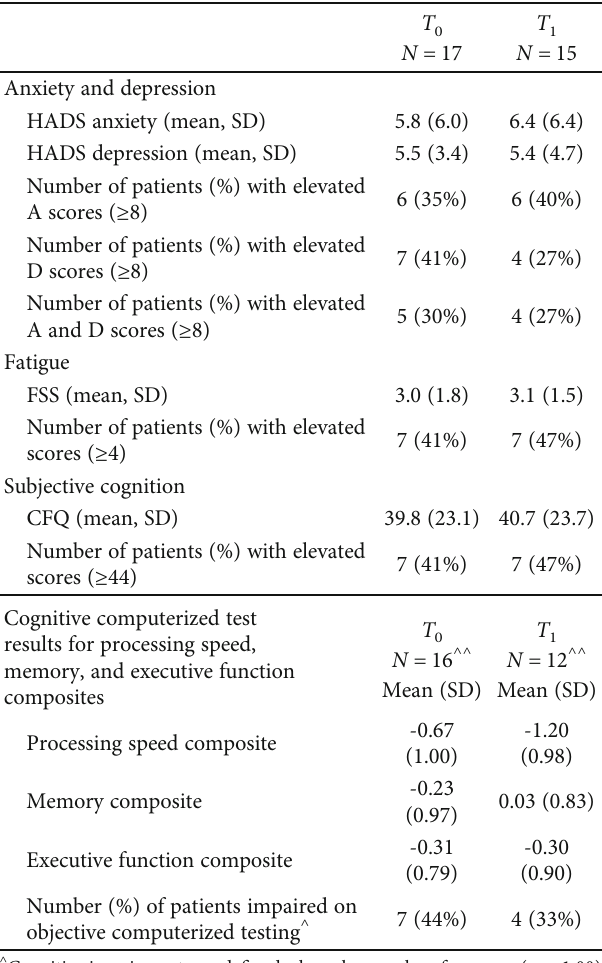
Table 4: Descriptive statistics of anxiety, depression, fatigue, subjective and objective cognitive impairment, and number of patients